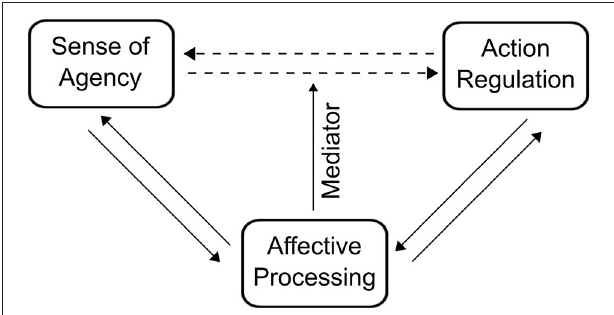
FIGURE 1 | Schematic representation of the proposed relation between sense of agency, affective processing, and action regulation. The model assumes a bidirectional relation between affective processing and sense of agency, as well as between affective processing and action regulation. Importantly, affective processing partially mediates the influence between sense of agency and action